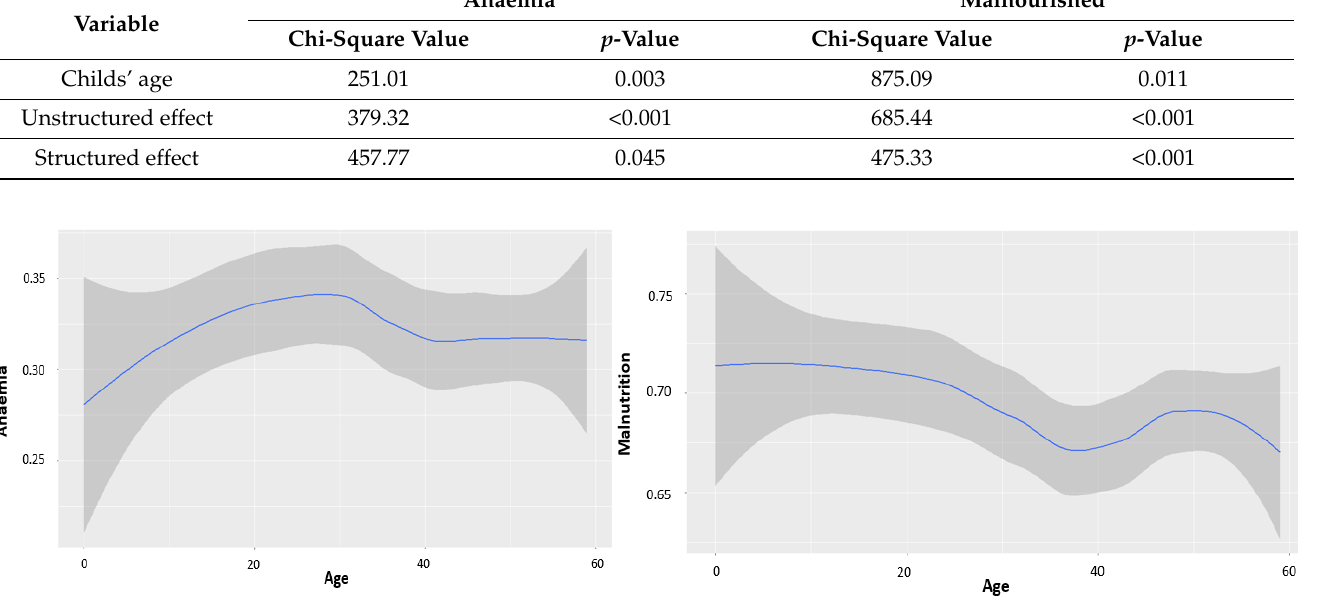
Figure 5. Estimated effect of the structured spatial effect on anaemia. ( Left ) Angola, ( middle ) Sene- gal, and ( right ) Malawi. 3.5. Estimated Joint Probability of Malnourishment and Anaemia From the copula regression model, the joint probabilities were calculated and aver- aged over the districts or regions. Figures 6 – 9 display the joint probabilities for each com- bination of the malnourished and anaemia outcomes. Figure 6. Joint probability of a child being malnourished and anaemic. ( Left ) Angola, ( middle ) Sen- egal, and ( right ) Malawi.